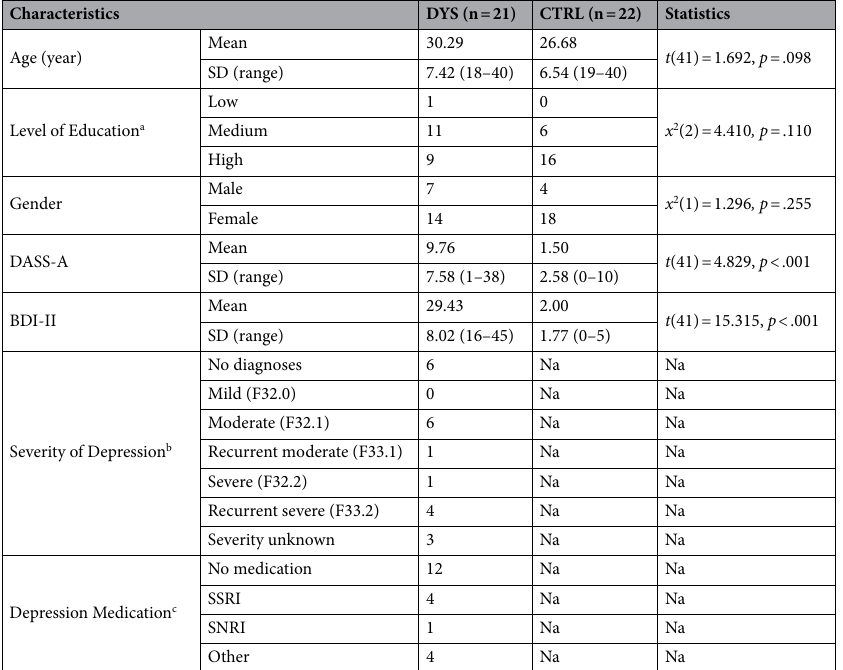
Table 1. Demographic and clinical information for each group. Statistics present independent t-test or x 2 test values investigating the group differences. DYS dysphoric group, CTRL control group, SD standard deviation, BDI-II Beck’s Depression Inventory, Second Edition, DASS-A Depression, Anxiety, Stress Scales, Anxiety scale (Lovibond and Lovibond 1995). a Low = education level under high school, Medium = education level at high school or vocational school, High = education level at university. b Depression severity based on participants self-report on their diagnosis or diagnosis given by project doctor. The diagnosis of depression was in accordance with the International Classification of Diseases and Related Health Problems, 10th Revision (ICD-10; World Health Organization, 2010) criteria. There is missing information related to disease severity from three participants, which is reported as severity unknown. c SSRI selective serotonin reuptake inhibitor, SNRI serotonin and norepinephrine reuptake inhibitor, Other other antidepressant